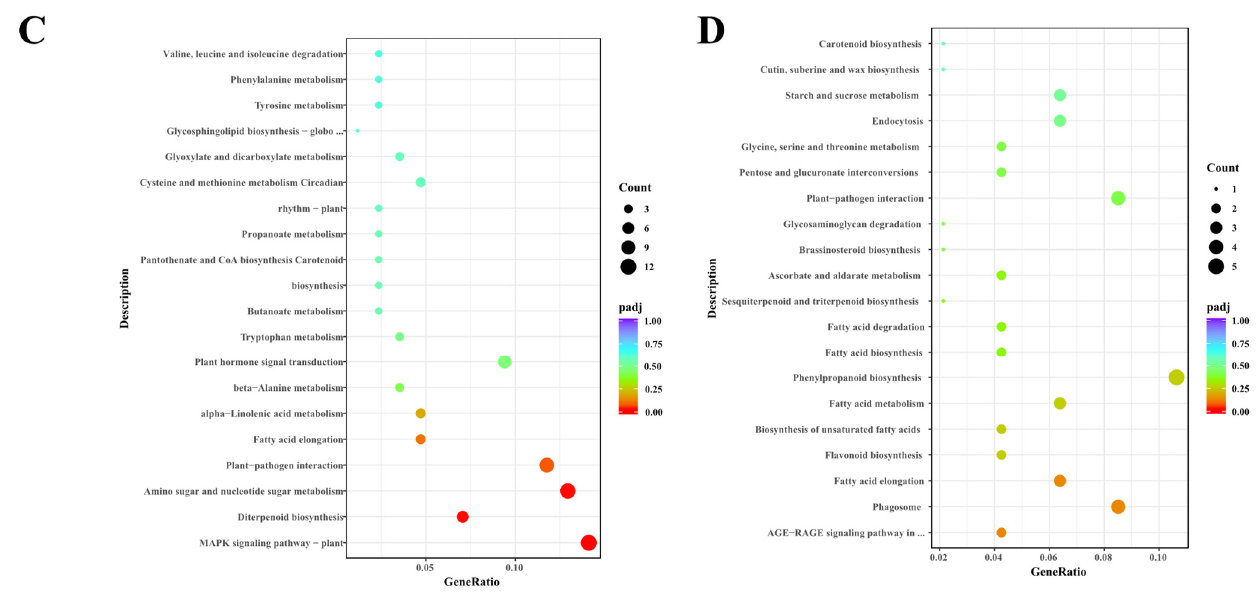
Figure 7. GO and KEGG enrichment analyses of differentially expressed genes (DEGs) at the S9 stage during anther development in osccr18 mutants and WT. ( A , B ) GO enrichment analysis of up– and downregulated DEGs. ( C , D ) KEGG pathway enrichment analyses of up– and downregulated DEGs. In both the GO and KEGG analyses, the top 20 most represented categories were shown.